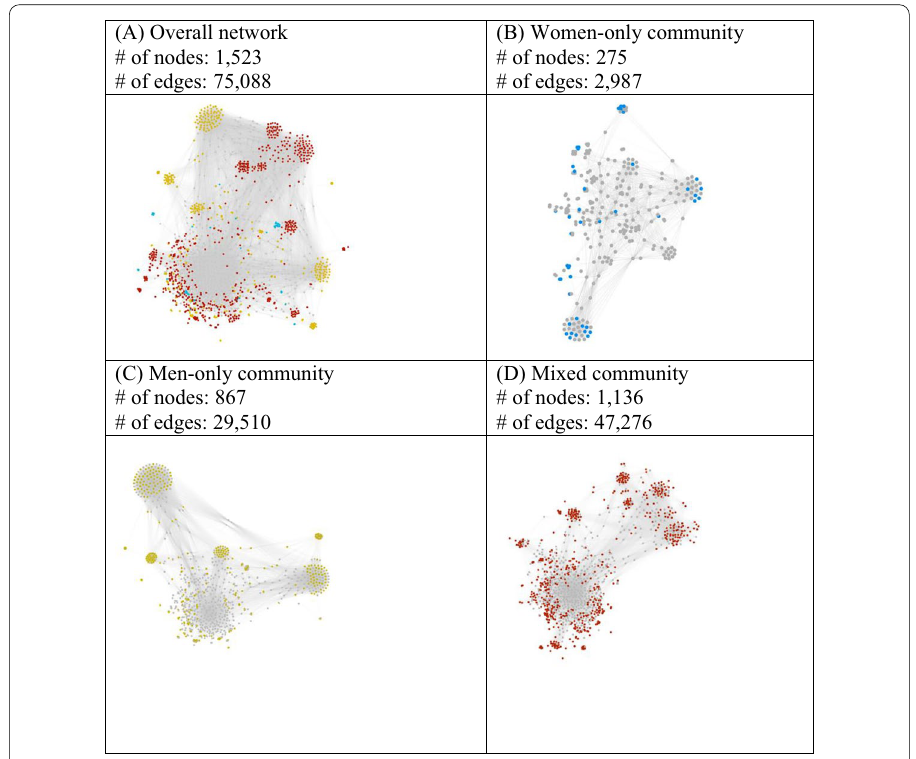
Fig. 2 Share of ‘exclusive’ gendered communities in overall